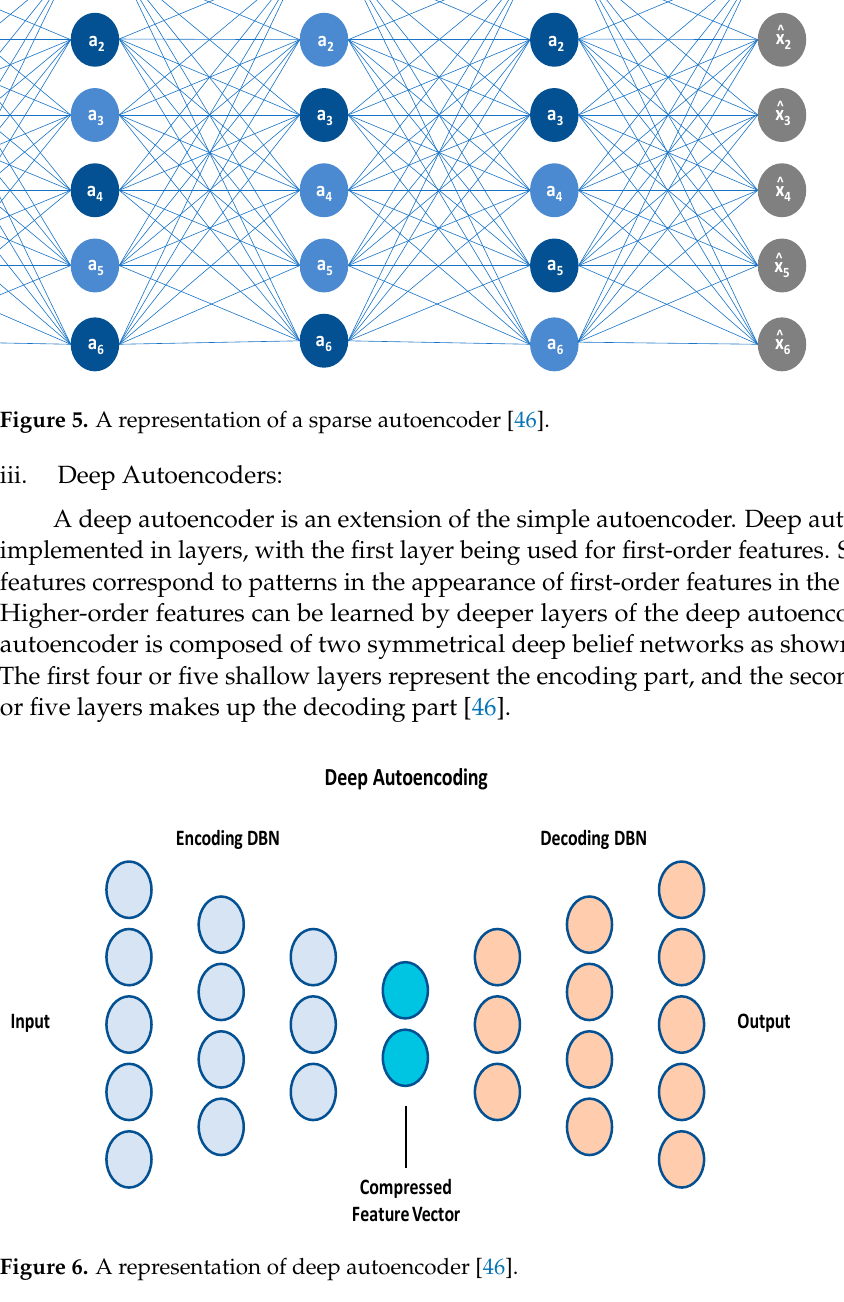
Figure 6. A representation of deep autoencoder [46].